Question: What style of plot is this figure drawn as?
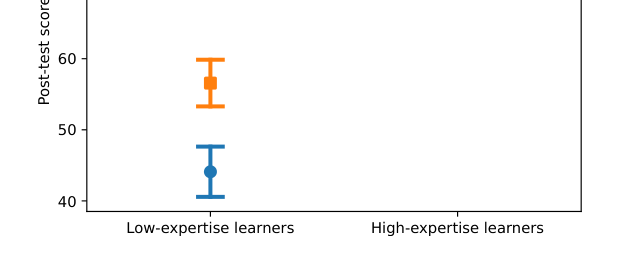
Answer: bar